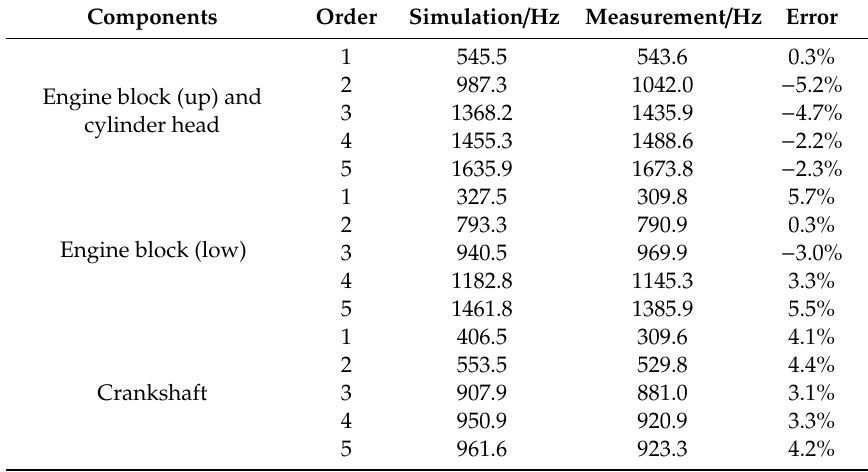
Table 3. Modal frequencies of components: comparison of the results from the simulation and measurement.